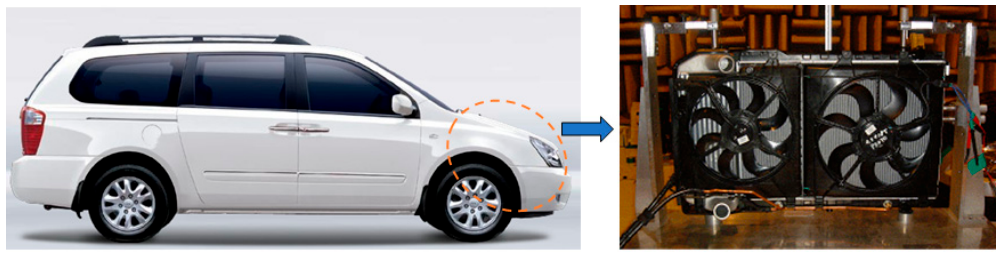
Figure 1. Automotive cooling axial fans.